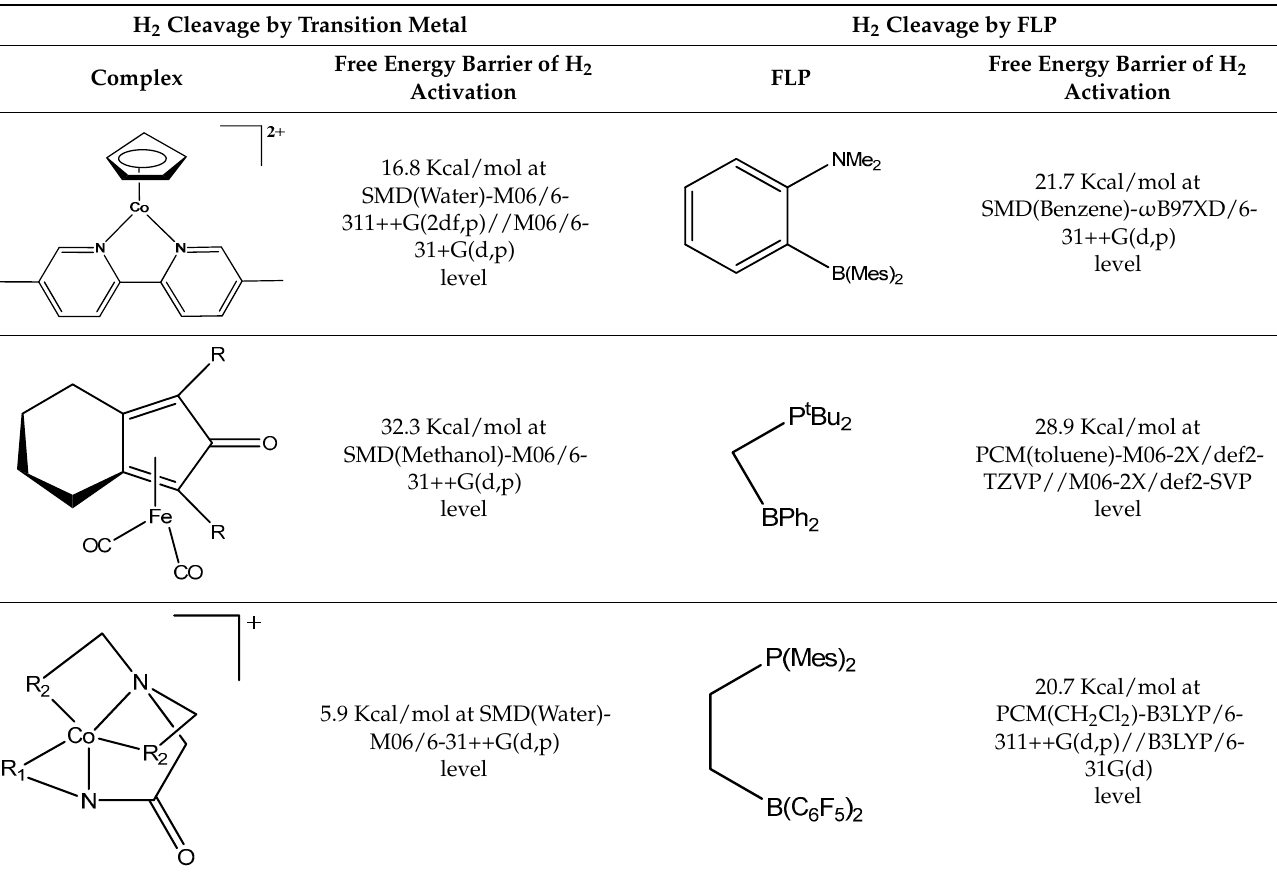
Table 3. A comparison of energetics for H 2 activation by TM and FLPs.